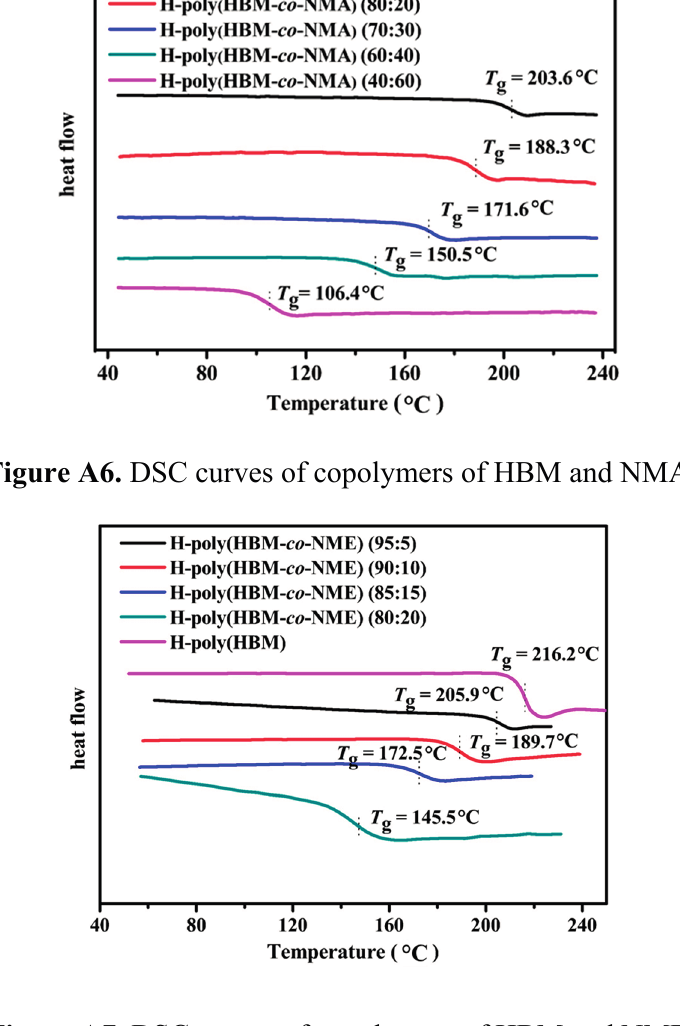
Figure A7. DSC curves of copolymers of HBM and NME.